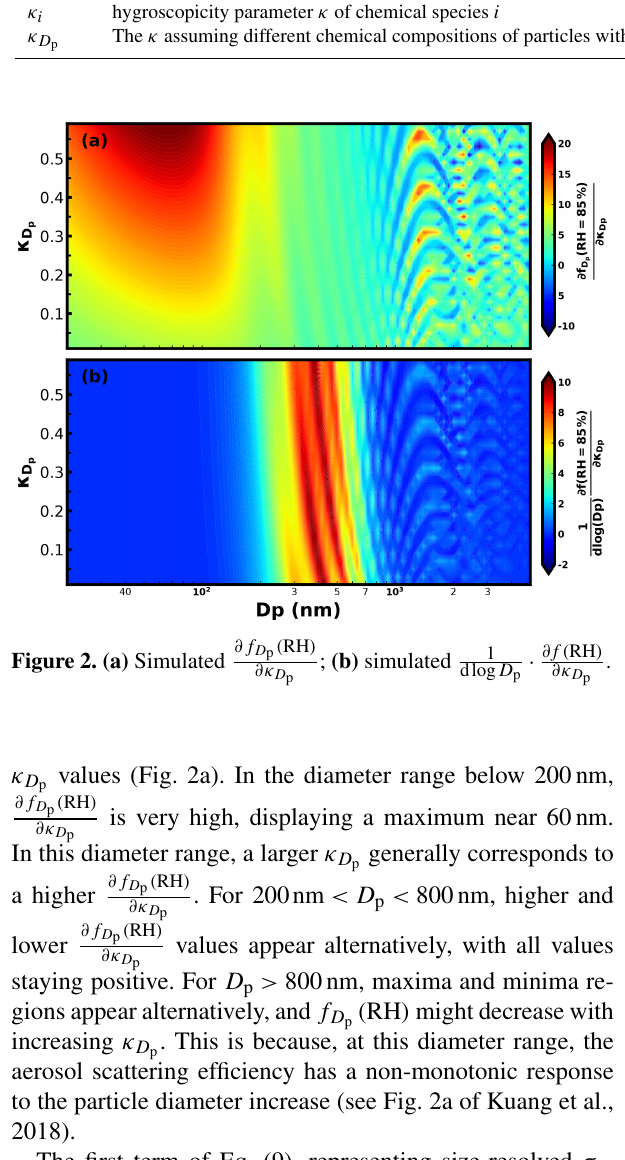
Table 2. Different κ and their physical meanings. κ f( RH )